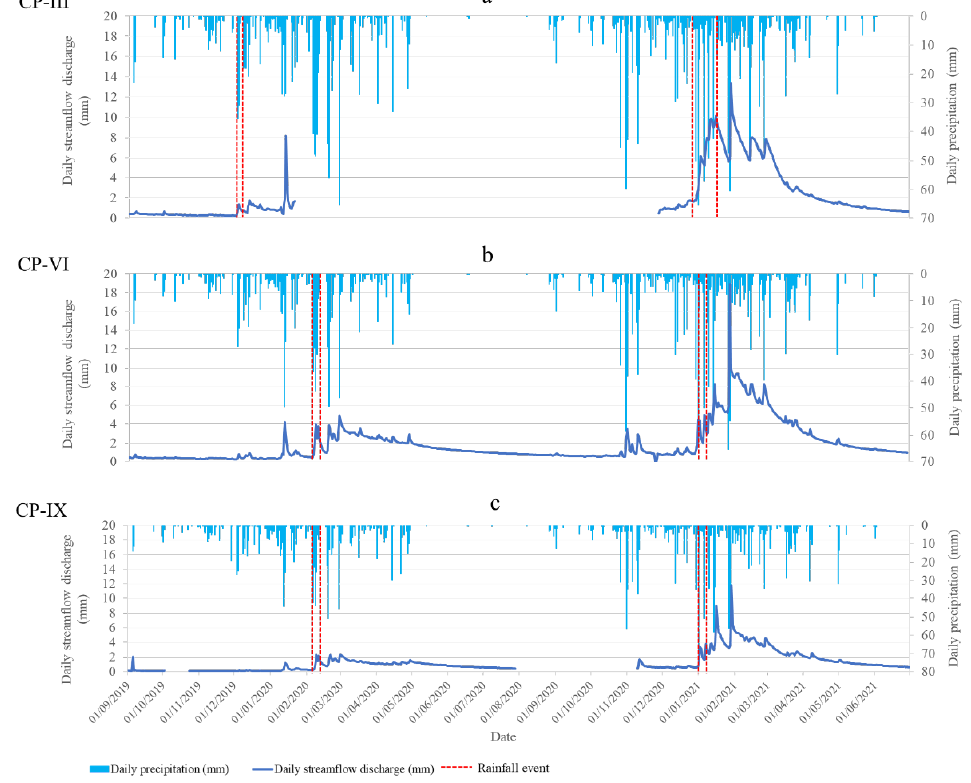
Figure 3. Depictions of the relationship between precipitation and streamflow discharge for: ( a ) CP- III; ( b ) CP-VI; ( c ) CP-IX.